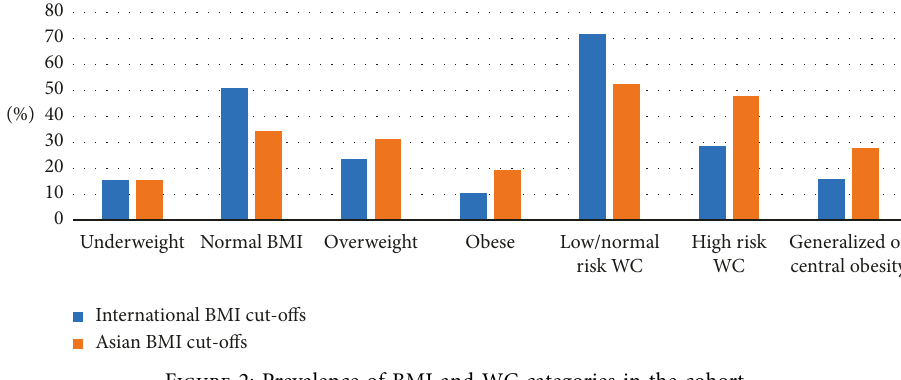
Figure 2: Prevalence of BMI and WC categories in the